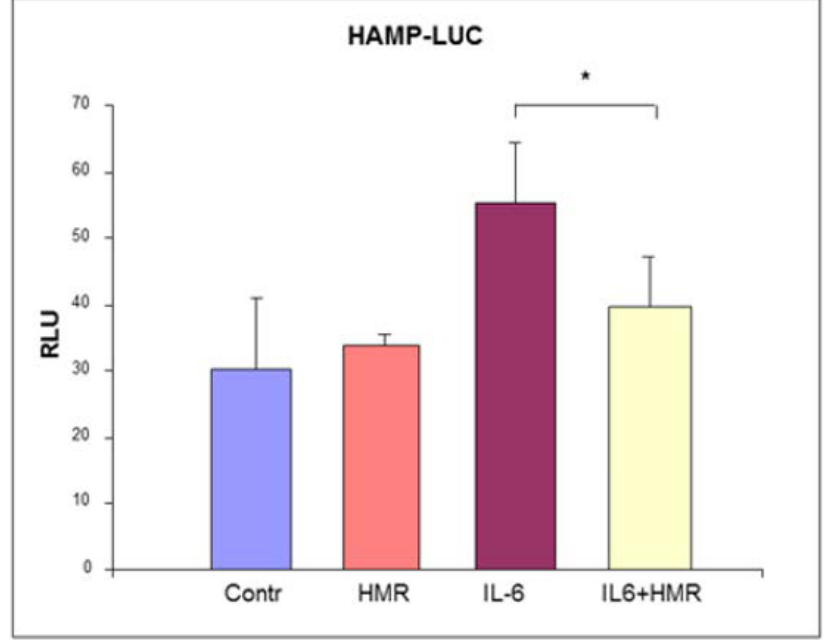
Figure 4. Caco-2 cells were transfected with pGL2-HAMP-LUC plasmid and treated with 50 ng / mL IL-6 in the presence or absence of 1 µ M HMR. HAMP promoter activity was measured as Relative Luciferase Units (Firefly luciferase units, normalized with Renilla luciferase units), in comparison with untreated cells. The results are presented as mean ± SD of three experimets. * p value < 0.05